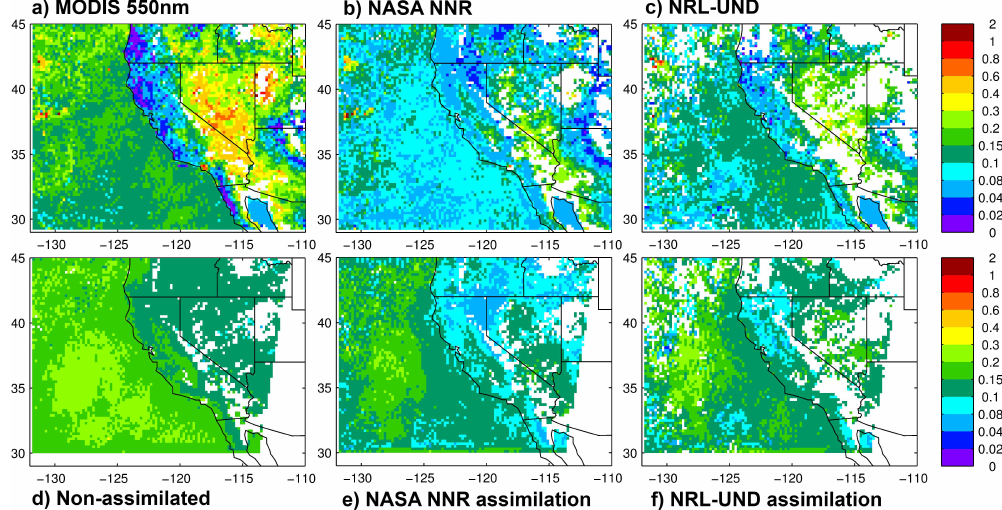
Fig. 5. May 2010 average maps of operational MODIS Terra (a) , NASA NNR (b) and NRL–UND (c) products at 550nm for the same MODIS Terra data, non-assimilated model (d) and assimilated estimates (e, f) . While the non-assimilated model is masked by the NASA NNR product, the assimilations are masked by each data ingested. MODIS data (a) are not quality controlled by cloud fraction or quality flags, as done during